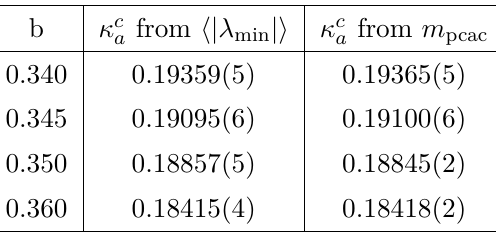
determined from the vanishing, as a a